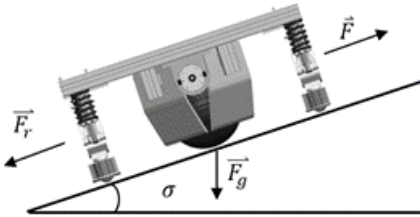
Figure 10. Forces diagram.